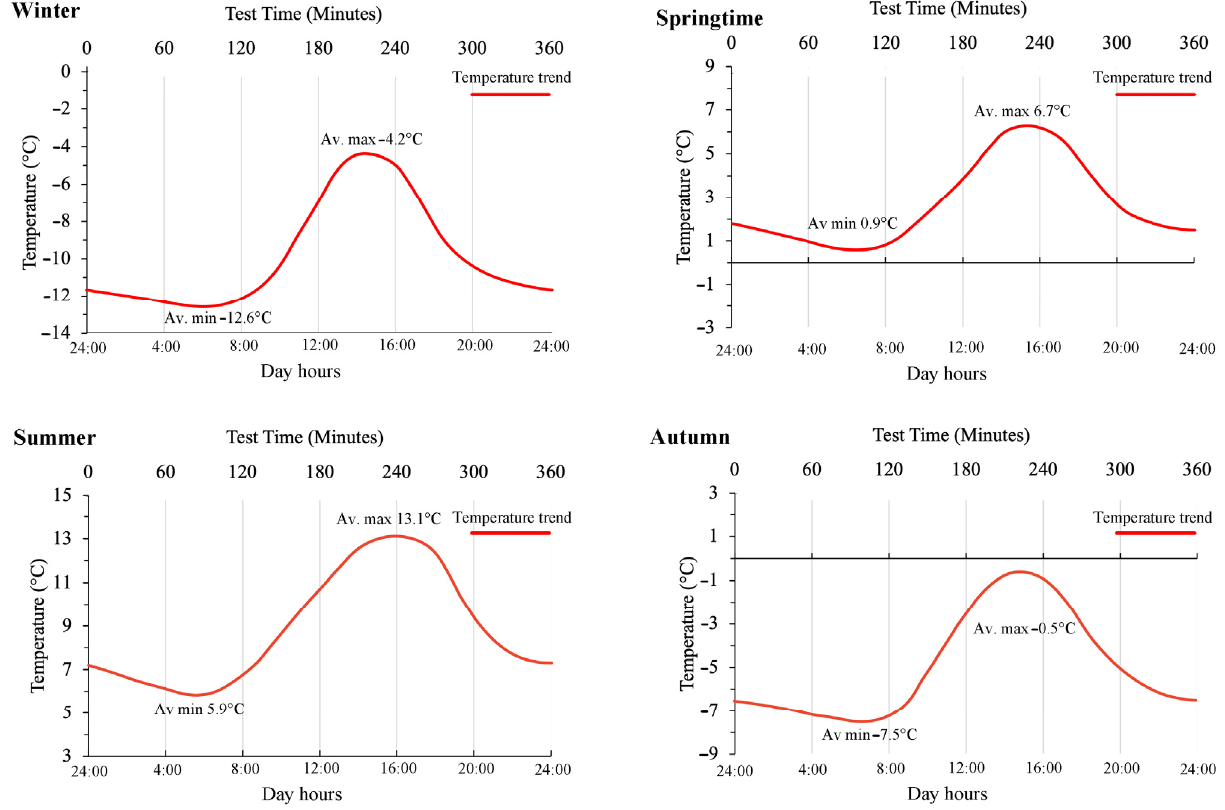
Figure 4. Climatic chamber cycle parameters set up for each season to artificially reproduce the